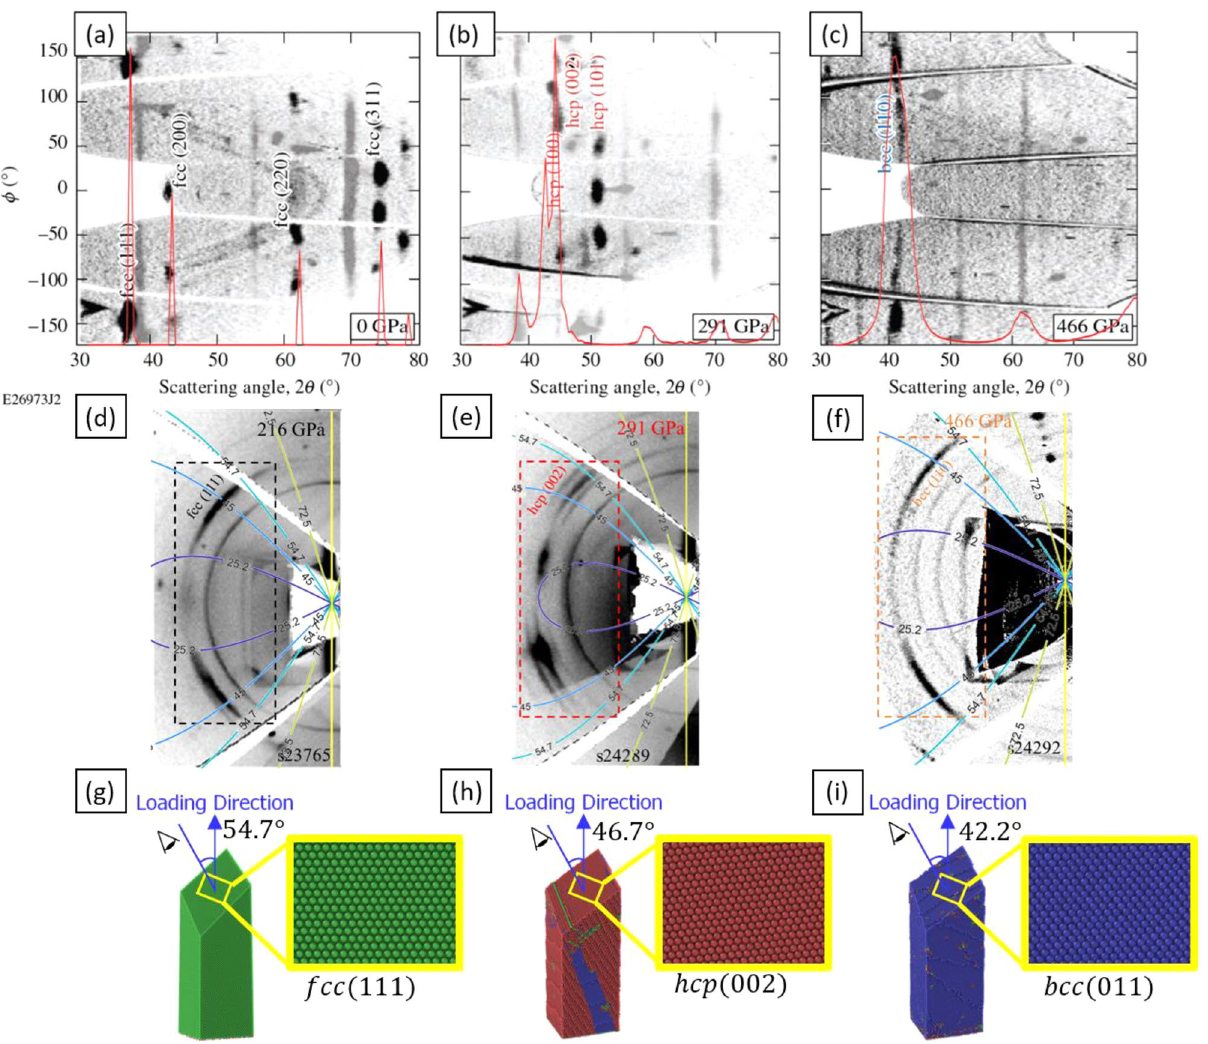
Figure 5. ( a – c ) Experiment and virtual XRD data taken at different stage of the ramp loading. The experimental data are taken at 0 GPa, 291 GPa and 466 GPa respectively. The virtual XRD data are taken at 0 GPa,76 GPa and 399 GPa respectively. Notice the single crystal diffraction Laue spots from the diamond and LiF ablator/window plates are also presented and artificially dimmed to highlight Al diffraction signature. ( d – f ) Stereographic projection of the diffraction data from experiment taken at different stress (216 GPa, 291 GPa and 466 GPa). The black, red, and blue boxes enclose the Debye–Scherrer rings for the fcc (111), hcp (002), and bcc (110) planes, respectively. The colored solid curves superimposed on the figures indicate constant χ , (i.e., the angles between the loading direction and the diffraction plane norms). ( g – i ) Representative slices of the atomic configurations observed from setup II at 0 GPa, 76 GPa and 113 GPa, respectively. Coloration schme is the same as Fig. 2. The magnified areas indicate the close packed planes—fcc (111), hcp (002) and bcc (011), whose normals have angles of 54.7°, 46.7° and 42.2° with respect to the loading